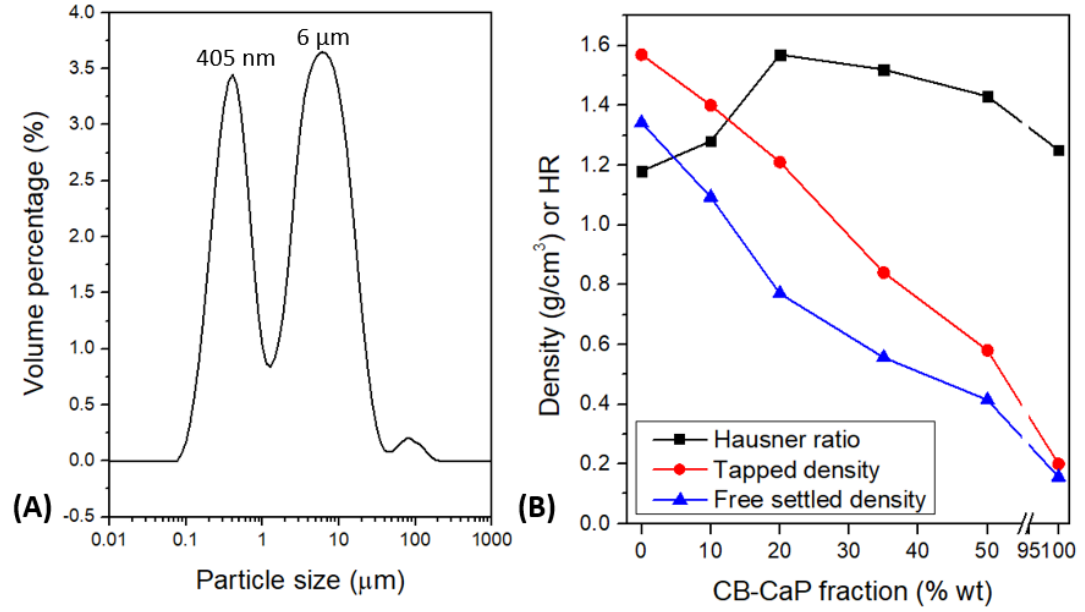
Figure 2. Particle size distribution of CB-CaP powder measured with laser diffraction ( A ) and tapped density, free settled density and Hausner ratio of AP40mod powder (45 – 100 µm) with increasing amounts of CB-CaP powder ( B ). Standard deviations for density measurements are small (<0.01 g/cm 3 ) and therefore are not reported in the graph.